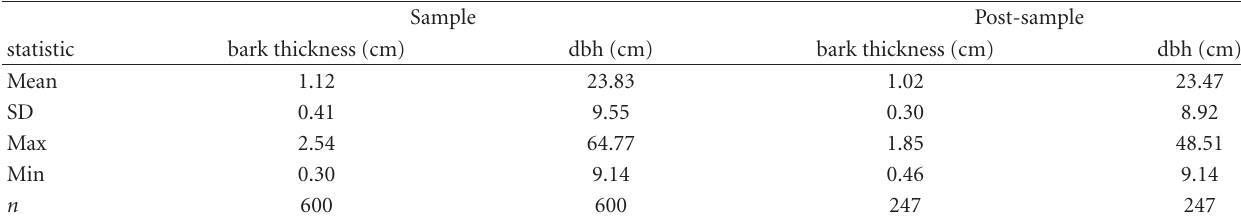
Table 1: Summary statistics of sample and post-sample tree records.